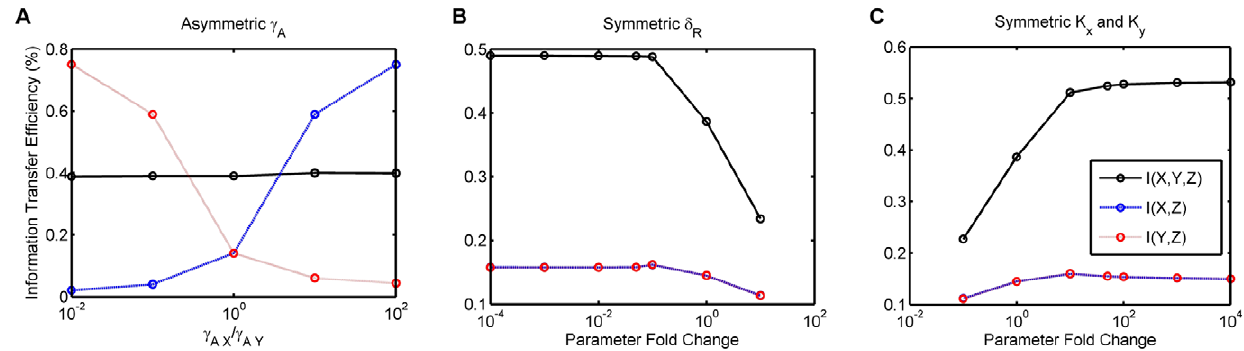
Figure 4. Parameter effects on information transmission for Model A. ( A ) Information transfer efficiency (as a percentage of the total uncertainly in the external distribution of ligands) vs. the ratio of the rates of association of the RSmad to the X and Y receptors. ( B ) Information transfer efficiency vs. symmetrical increase/decrease of receptor degradation rate from the standard parameter rate. ( C ) Information transfer efficiency vs. symmetrical increase/decrease of ligand binding rate from the standard parameter rate.